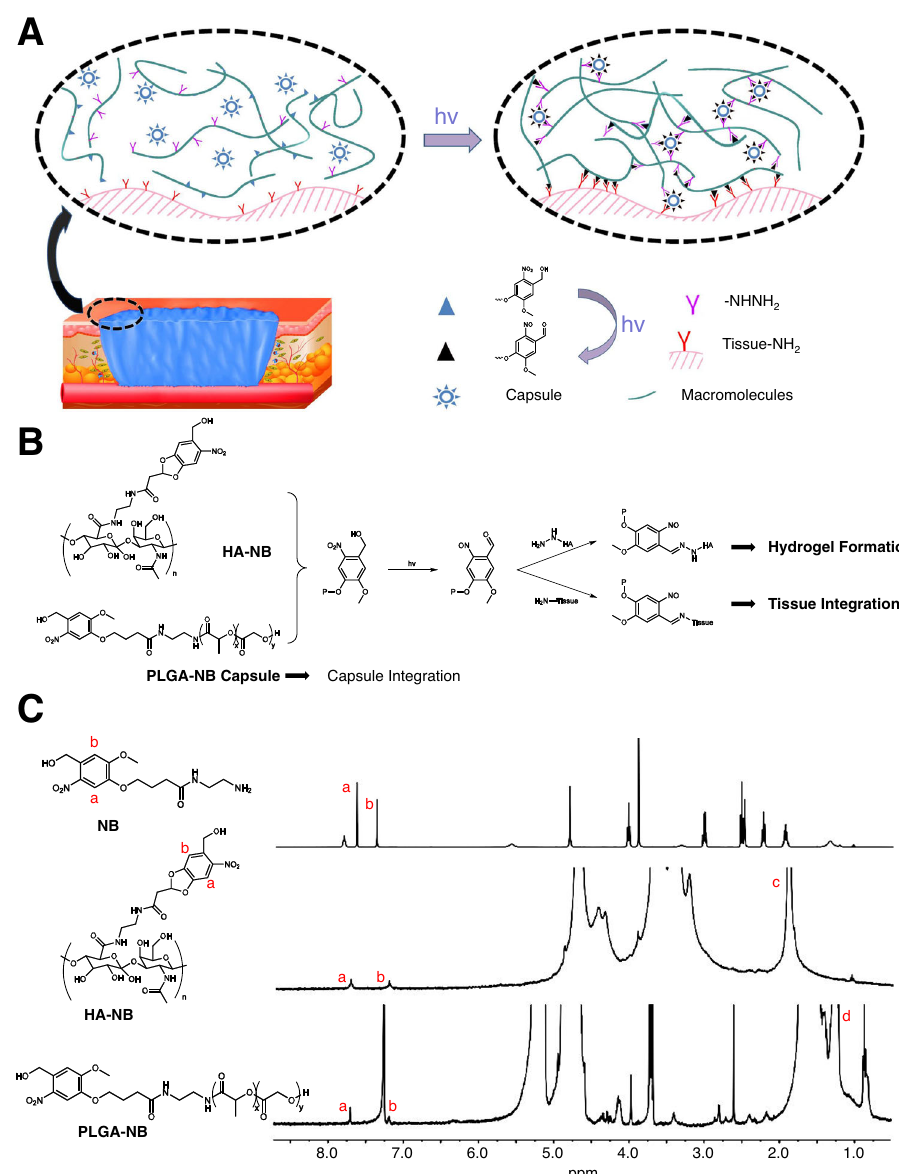
Fig. 1 Engineering PLGA microcapsules that can be integrated to skin wounds through photo-inducible crosslinking. A Schematic illustration of photo- induced crosslinking mechanism for tissue integration of hydrogel and PLGA-NB capsules. B Schematic illustration of the chemical structures of HA-NB and PLGA-NB, as well as photo-inducible integration of microcapsules with hydrogel and wounded tissue. C Structure characterization of NB, HA-NB, and PLGA-NB by 1 H NMR (400